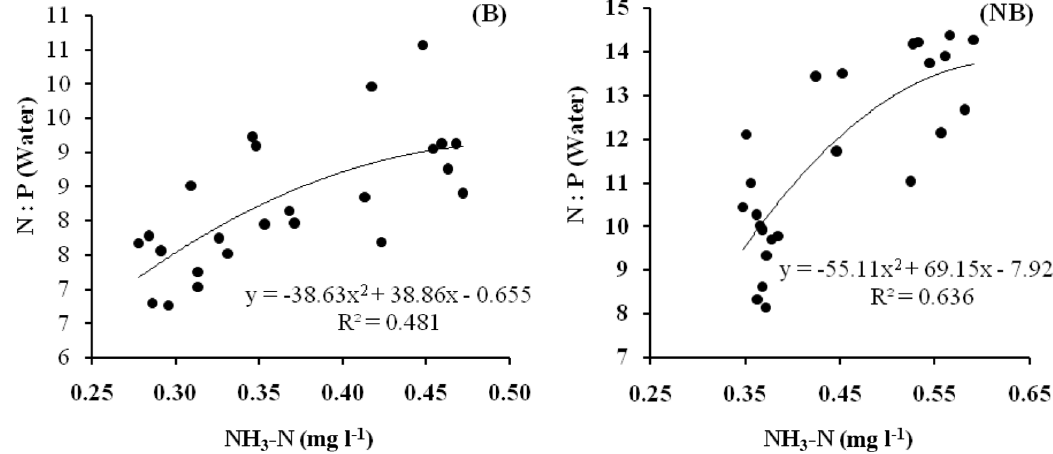
Fig. 4. Fitted relationship between NH 3 -N and N:P ratio in without neem (B) and neem based (NB) bio fl oc system.